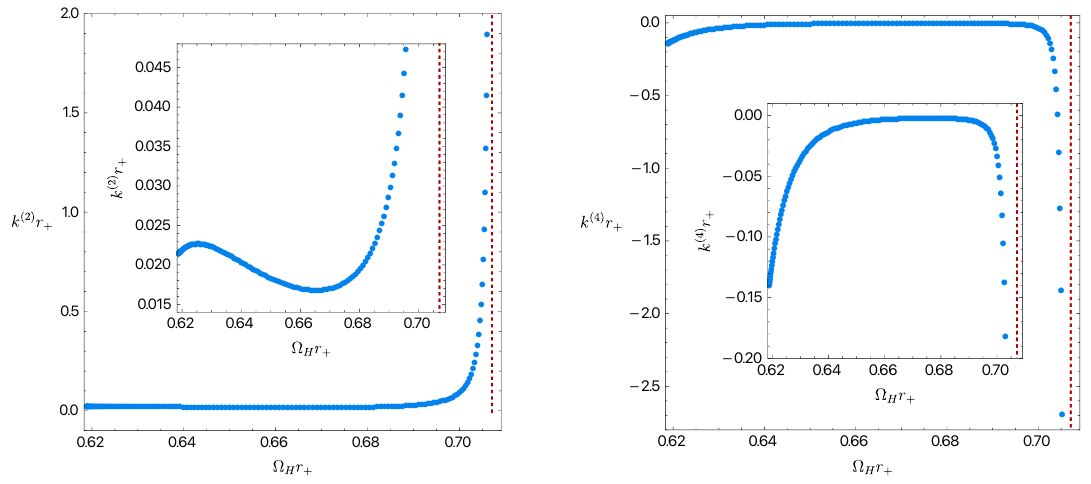
a . The vertical red dashed line represents e √ 2 . Recall that the leading wavenumber e k (0) is given in